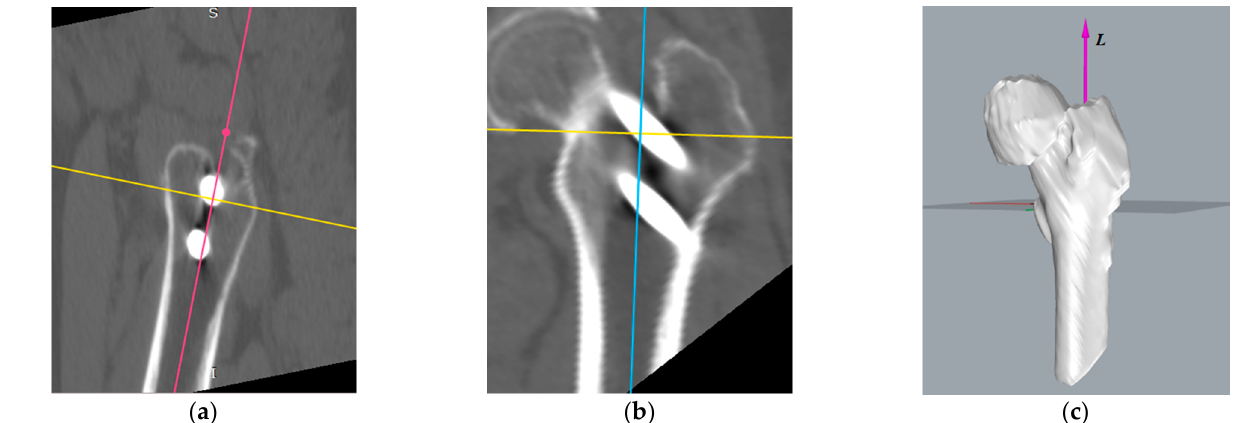
Figure 8. Manually matched and measured displacement of pins.